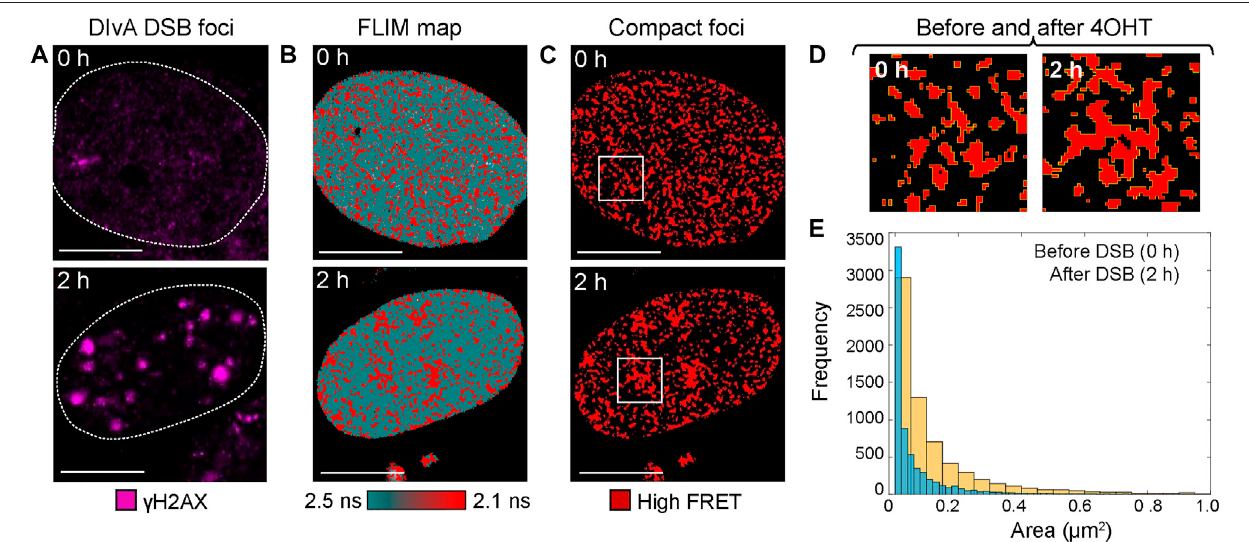
FIGURE3| ParticleanalysisofhistoneFRETinDIvAcellFLIMmapsrevealssub-micronchangesincompactchromatinnetworkorganizationuponDSBinduction. (A) DIvA nucleus expressing the histone FRET pair (H2B-eGFP and H2B-mCh) that has been fi xed with IF against γ H2AX before (top) versus after (bottom) 2 h of treatmentwith4OHT(scalebar10 μ m). (B) FLIMmapsofthecellspresentedinpanel (A) pseudo-coloredtoreporthistoneFRET(redpixels)versusnoFRET(tealpixels). (C) Localization of compact chromatin foci extracted from the histone FRET maps presented in panel (B) . (D) Zoom of region of interest (white box) in localization maps presented inpanel (C) . (E) Histogramofthesizeofcompactchromatin foci asdetectedbyhistoneFRETinDIvA before(blue) versusafter 2 h(yellow) oftreatment with 4OHT (N (cid:1) 6 cells, two biological